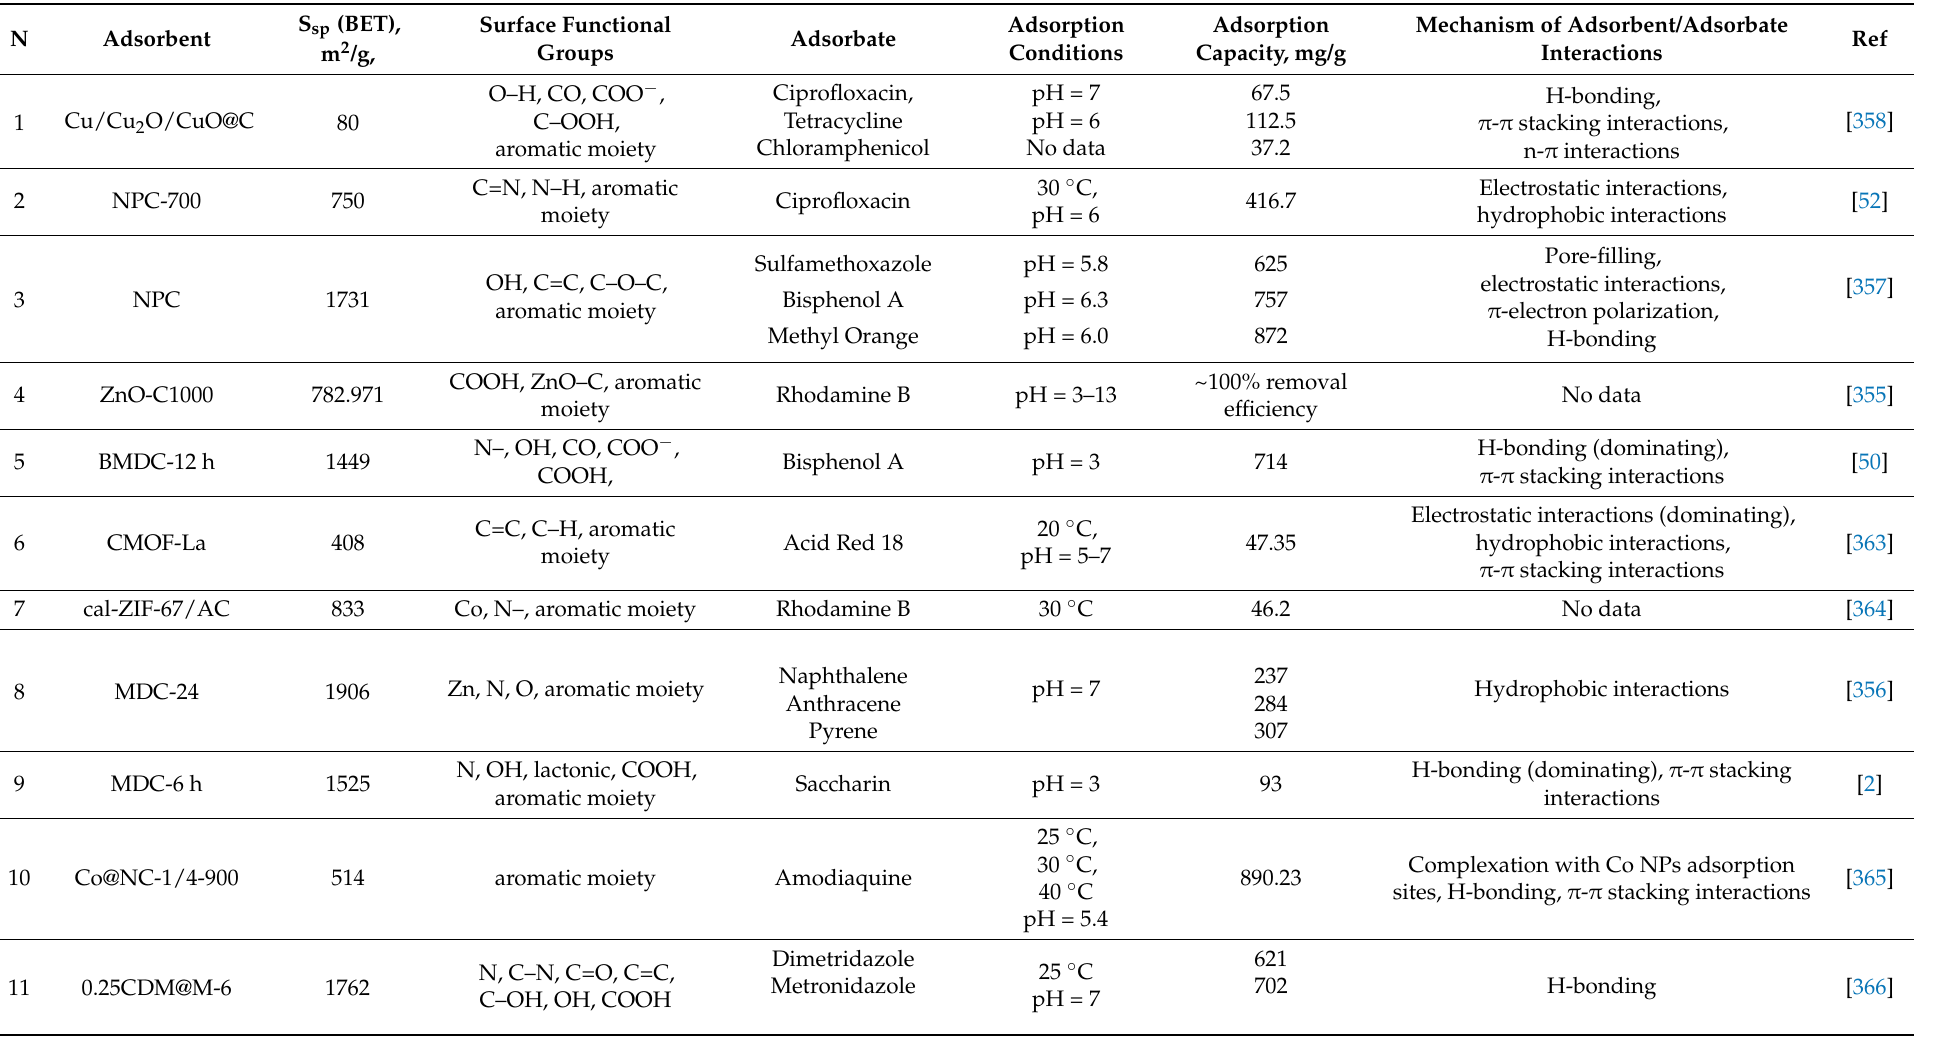
Table 4. Surface characteristics, adsorption capacity and mechanisms of the adsorption of organic pollutants using MOF-derived carbon